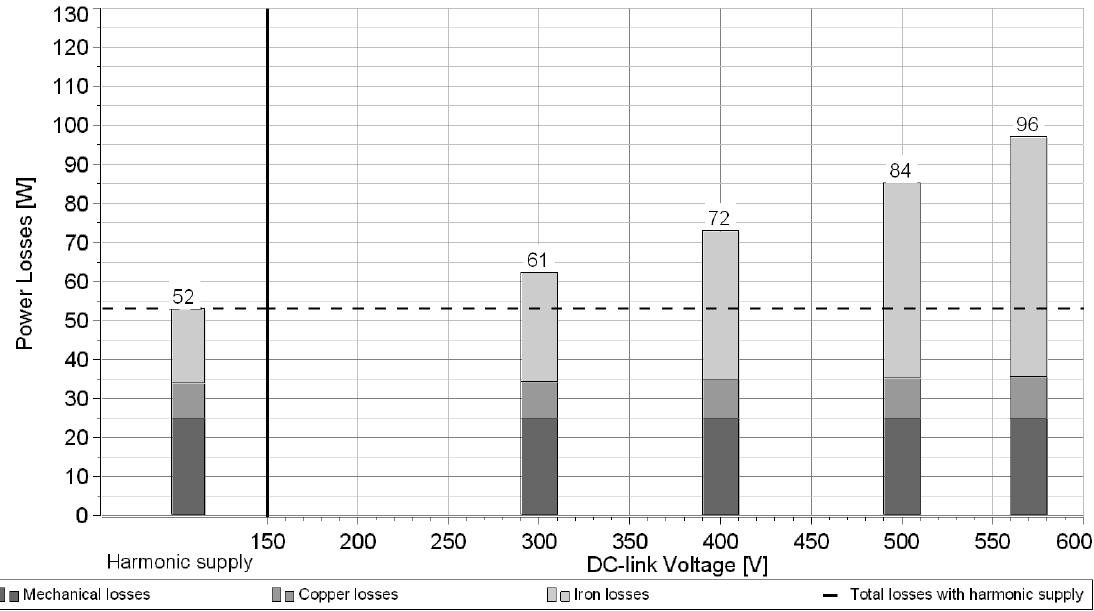
Figure 9. Motor speed 750 rpm and no-load condition: loss distribution in the case of a sinusoidal supply (left) compared to a loss distribution of the PTC-controlled IM (right) with the reference stator flux 1 Wb and different values of DC-link voltage.